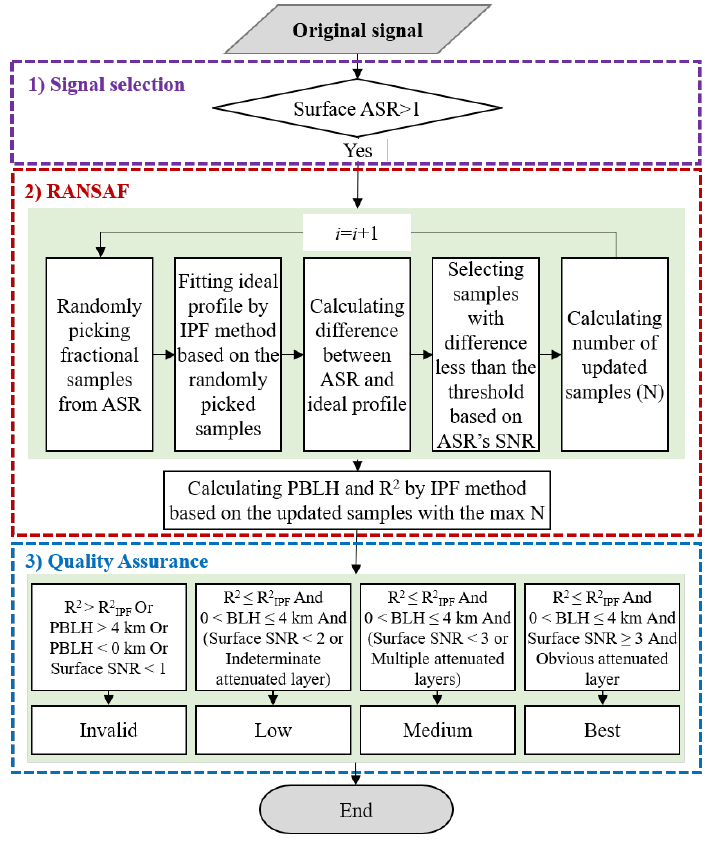
Figure 2. Flowchart of RANSAF method to determine the PBLH from the satellite-based lidar signal.